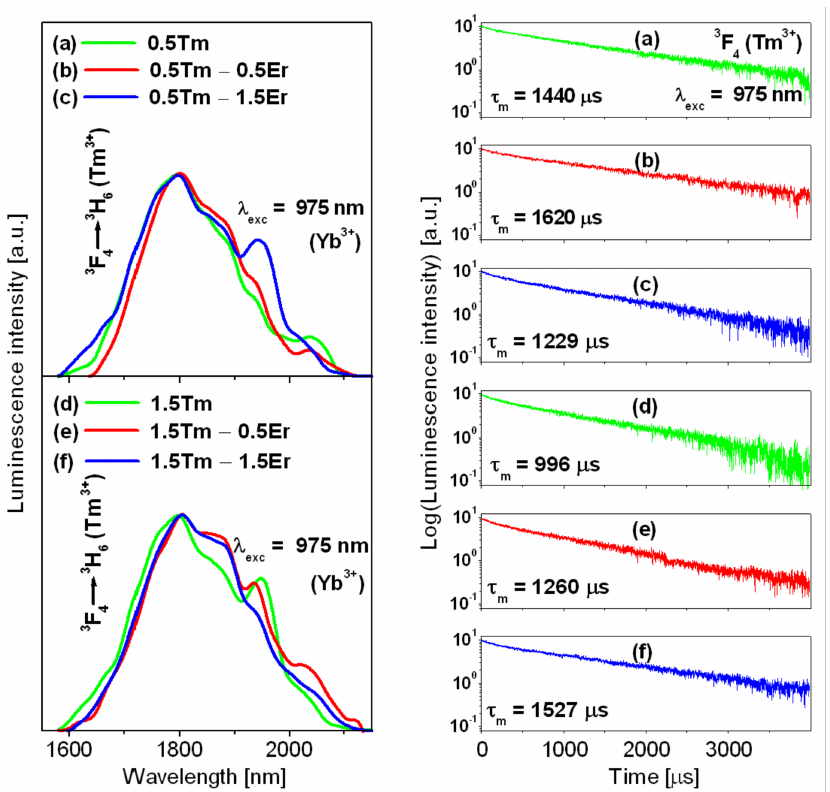
Figure 4. Normalized NIR luminescence spectra ( left ) and their decays ( right ) measured for lead germanate glass containing Yb 3+ /Er 3+ /Tm 3+ and Yb 3+ /Tm 3+ ions excited at 975